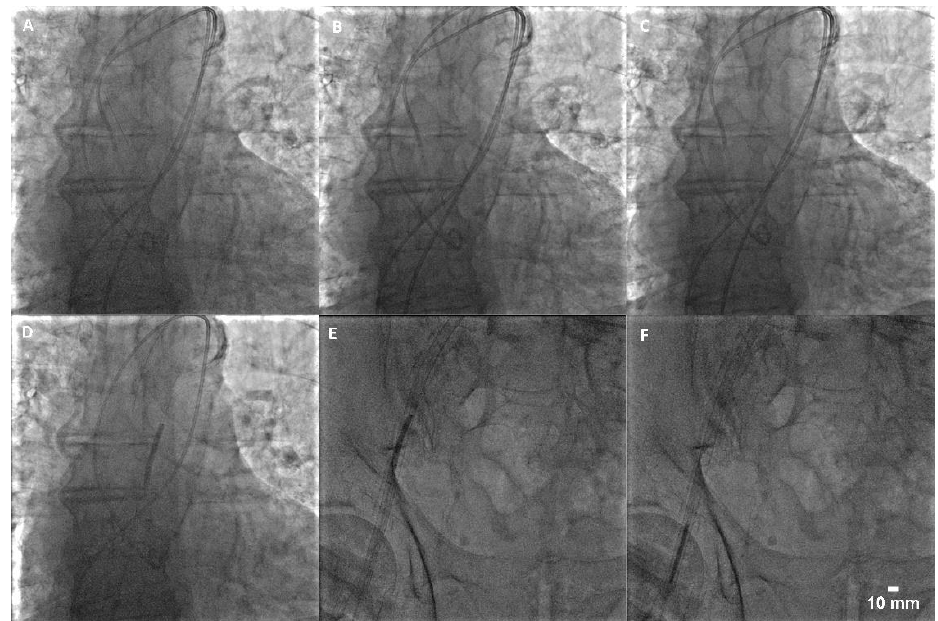
Figure 3. Step-by-step recapture of the severed sheath: ( A ) wiring; ( B ) balloon crossing; ( C ) balloon capture; ( D ) balloon snaring (aorta); ( E ) balloon snaring (introducer sheath); ( F ) balloon deflation and evacuation.